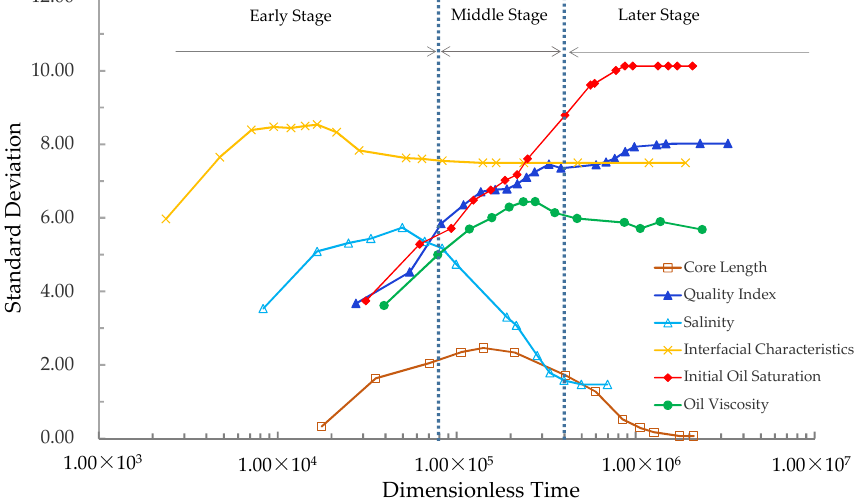
Figure 9. Relation curve of dimensionless time and discreteness of the controlling factors.